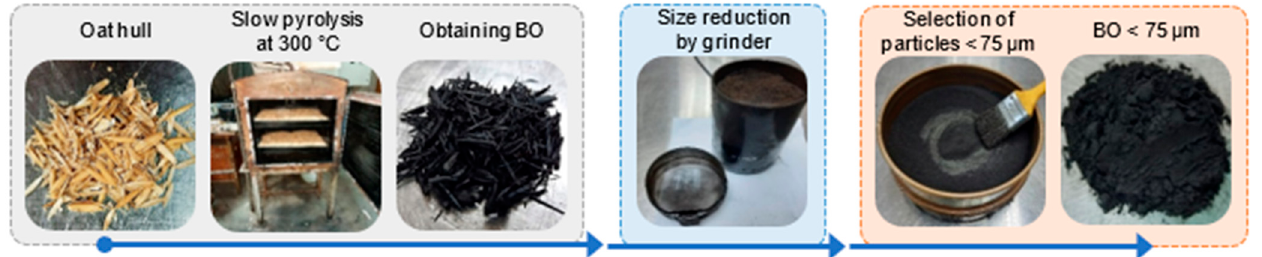
Figure 2. BO production sequence.